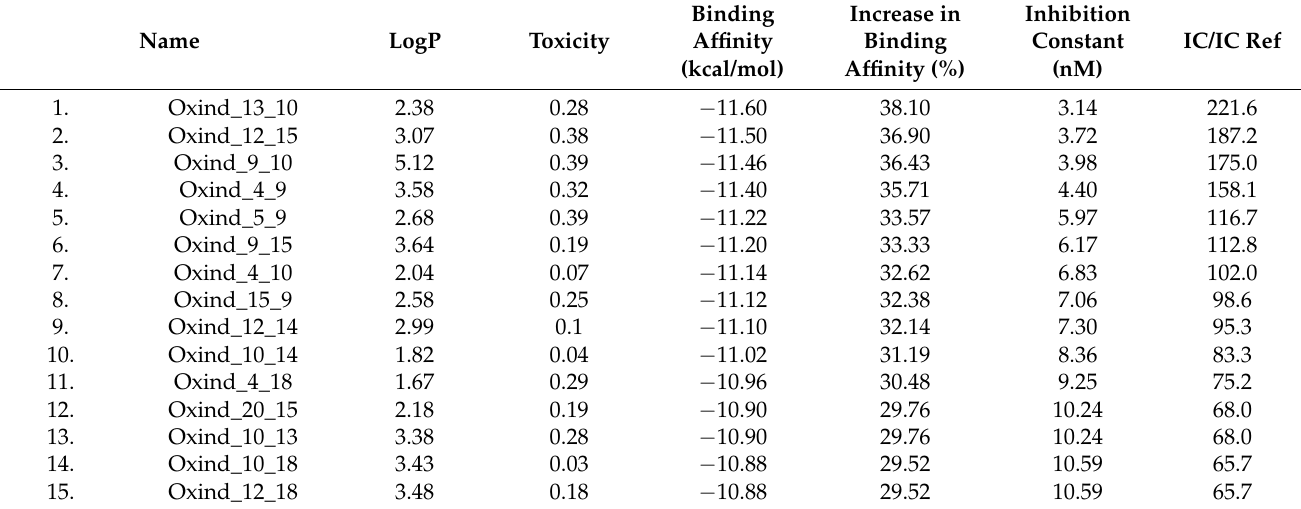
Table 2. The values of binding affinity and molecular parameters for the structures exhibiting the best properties. IC/IC ref represents normalized factors describing the decrease in inhibition constant relative to the reference system (IC ref = 696.17